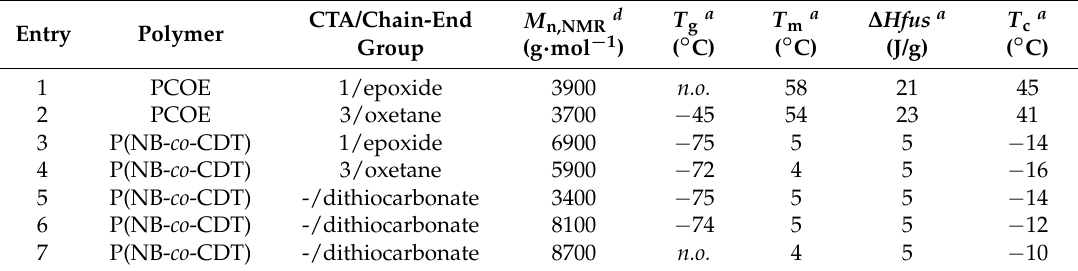
Table 5. Thermal transitions of the telechelic (co)POs a